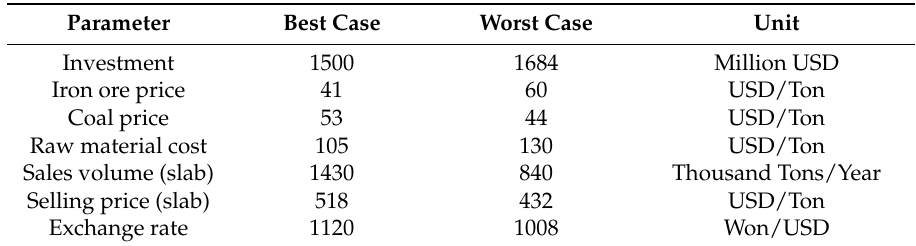
Table 6. Economic data for case study Project B.